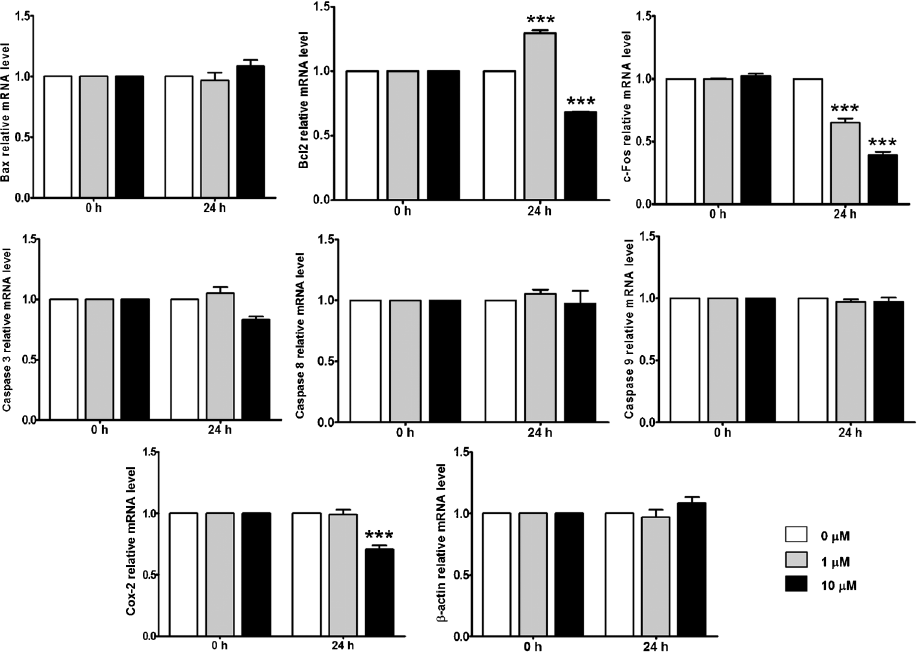
Figure 2. Effects of celecoxib (0, 1, and 10 m M) on H9c2 gene expression. Relative expression of Bax , Bcl2 , c-Fos , caspases , Cox-2 , and b -actin genes were measured after cells were incubated with the drug for 24 h. Data are reported as average of values of assays ±SD. All treatments were conducted in triplicate. ***P , 0.001, compared to 0 m M at 24 h (Dunnett test).